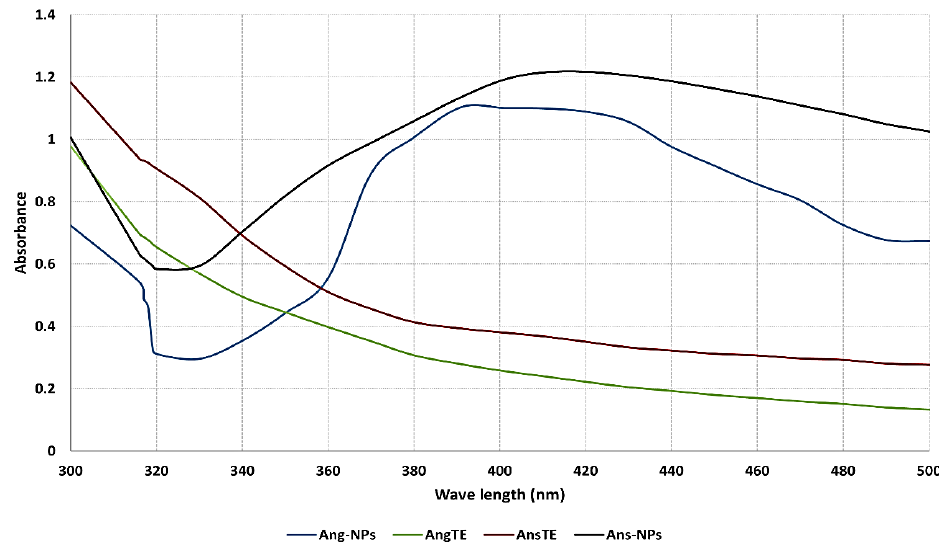
Figure 1. UV spectrum of the biosynthesized silver nanoparticles Ang-AgNPs and Ans-AgNPs compared to their extracts AngTE and AnsTE, respectively.